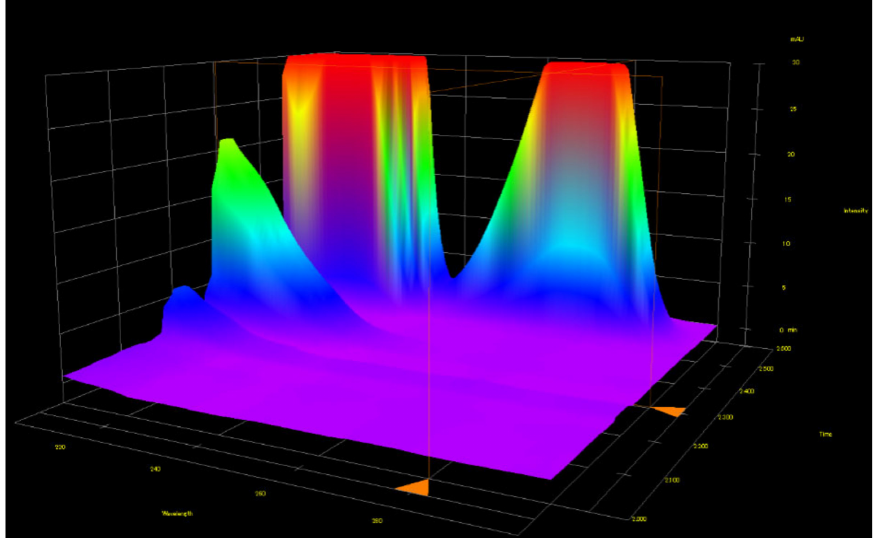
Figure 44. High resolution PDA detector full 3-D chromatogram confirms the identity of peaks with implying certain extent of confidence in peak recognition and measuring, with easily recognized characteristic UV-Abs spectrum of meldonium, annotated with marking triangle located at the axis presenting retention time.